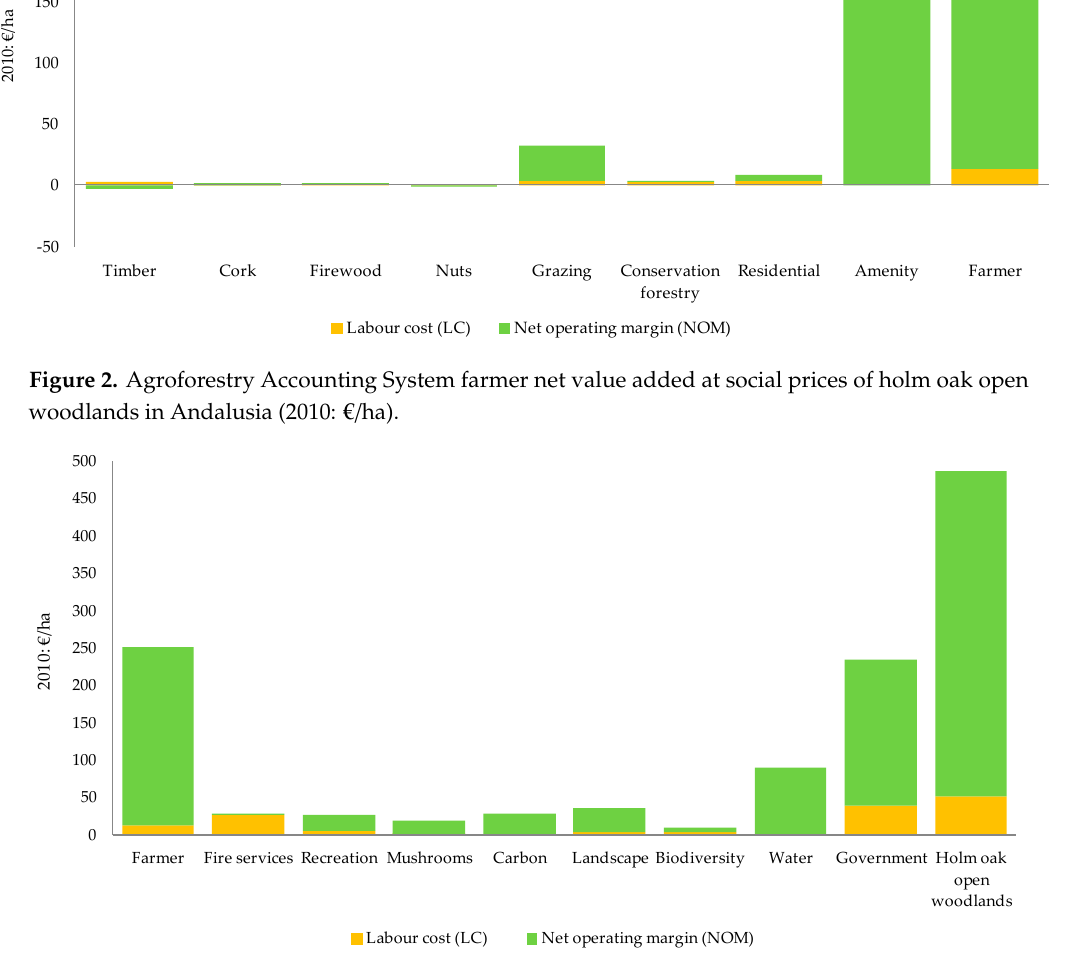
Figure 3. Agroforestry Accounting System total net value added at social prices of holm oak open woodlands in Andalusia (2010: €/ha).